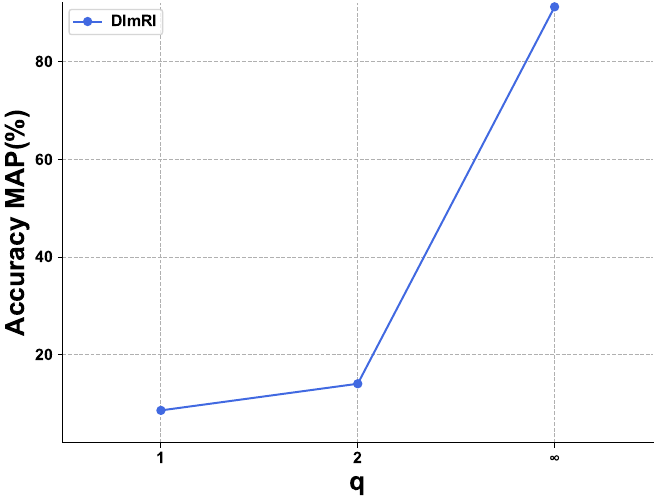
Figure 12. The figure shows the effect of q on the MAP score using our DlmRl.